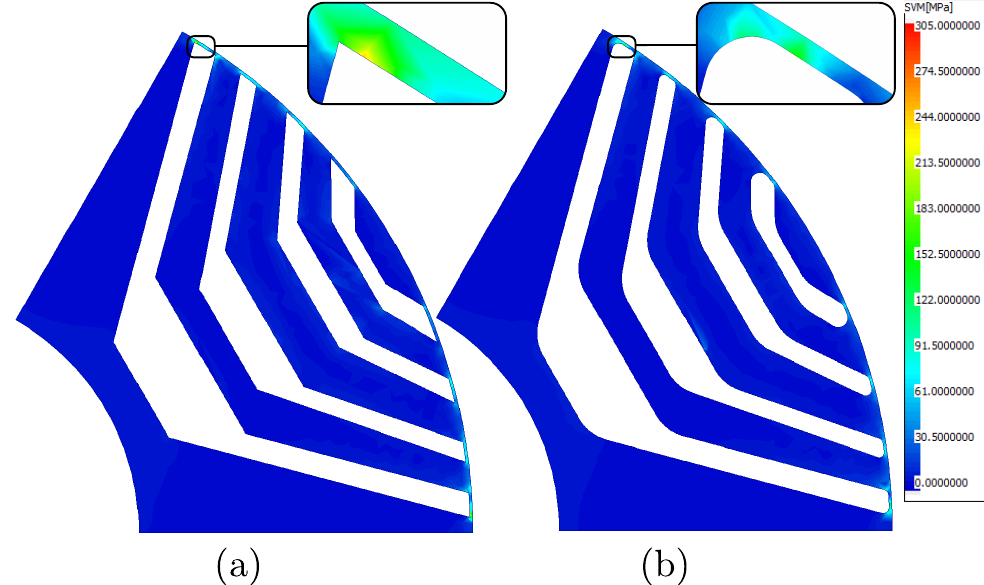
Figure 3. SyRM rotor mechanical stress distribution without ( a ) and with ( b ) barrier